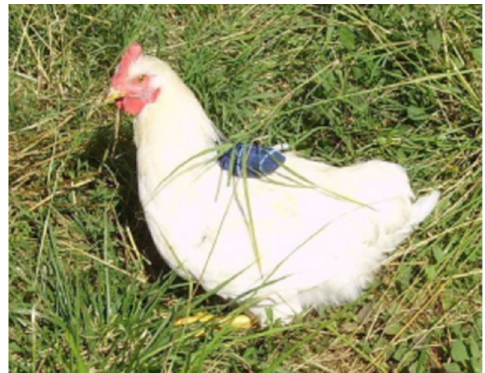
Figure 3. Chicken with the, Super Track stick GPS.